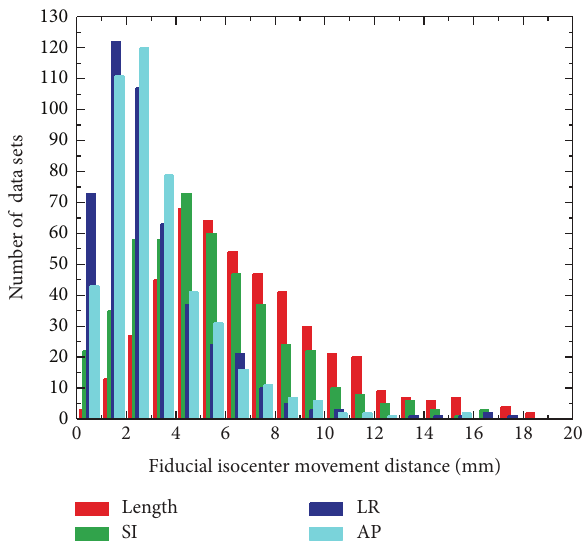
Figure 3: Histogram of the fiducial isocenter movement distance in different